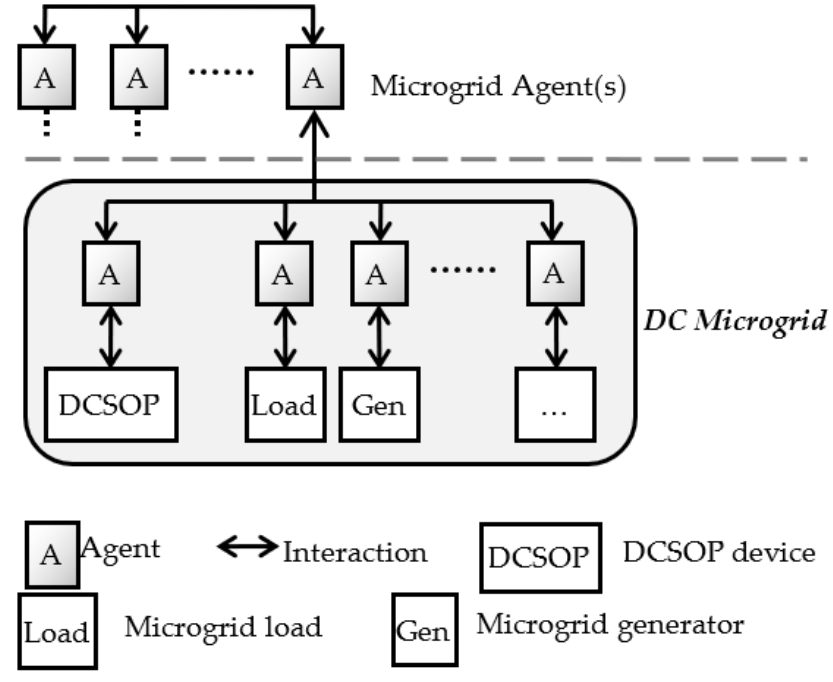
Figure 8. DCSOP multi-agent system structure.